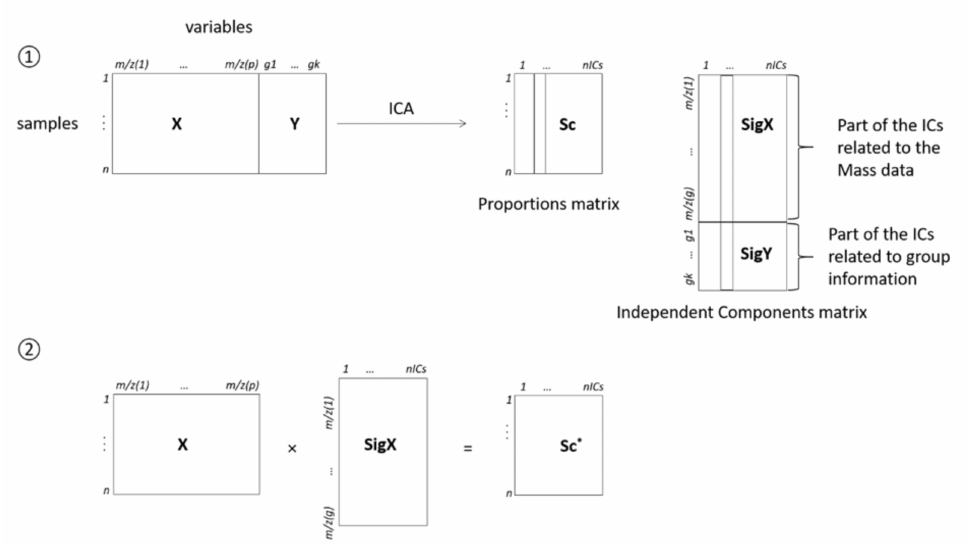
Figure 1. Schematic representation of ICDA. X is the matrix of mass spectra and Y is the group information matrix (there are as many columns as groups, and for each group, there is a 0 value if the corresponding sample does not belong to this group, and a 1 if it does). Sc is the proportion matrix, while SigX and SigY correspond to the parts of the signal matrix related to the mass spectra and to the group membership, respectively; Sc * is the proportion matrix obtained after removing SigY from the